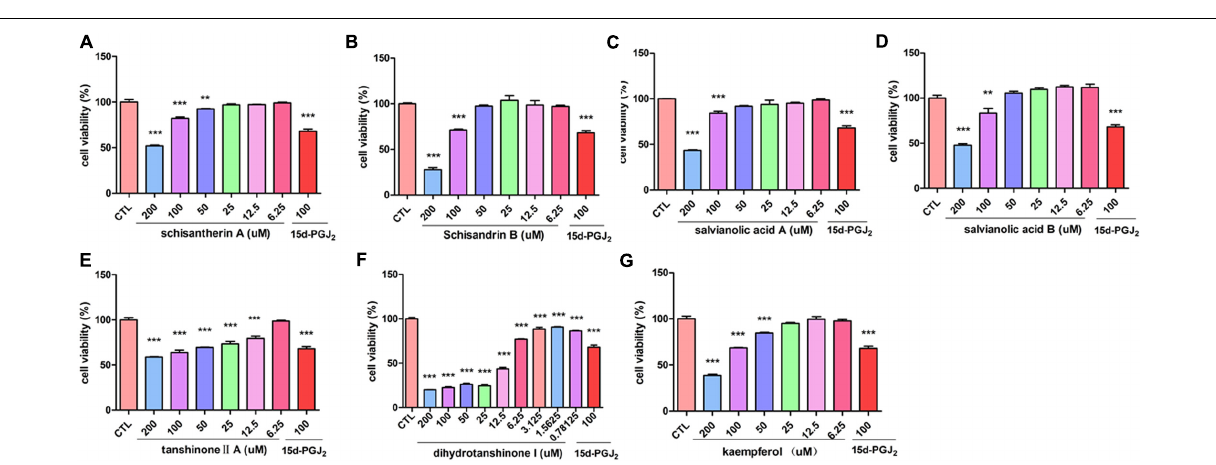
FIGURE 6 | Active components in FZHY inhibited human HSC-LX-2 activation. LX-2 cells were treated for 24 h with indicated concentrations of (A) schisantherin A, (B) schisandrin B, (C) salvianolic acid A, (D) salvianolic acid B, (E) tanshinone II-A, (F) dihydrotanshinone I, (G) kaempferol. CCK8 assay was used to measure the cell viability. Data were obtained from three independent experiments performed in triplicate and presented as means ( ± SD). ∗ P < 0.05, ∗∗ P < 0.01, ∗∗∗ P < 0.001 versus the control (CTL).